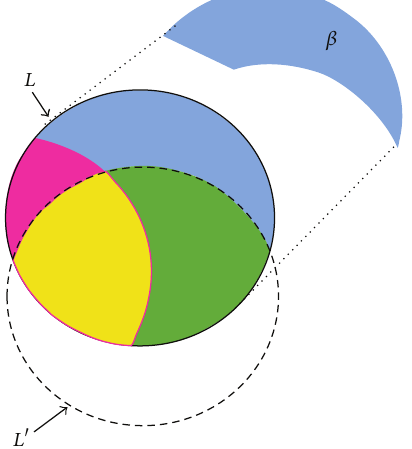
Figure 5: The set of sensitive itemsets that fail to be hidden.